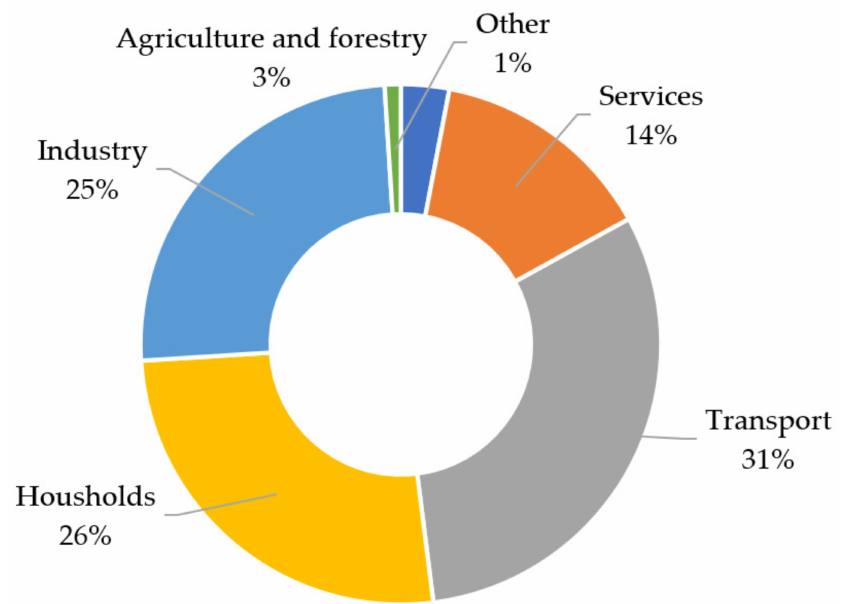
Figure 1. EU final energy consumption by sector in 2019 (developed by the authors based on